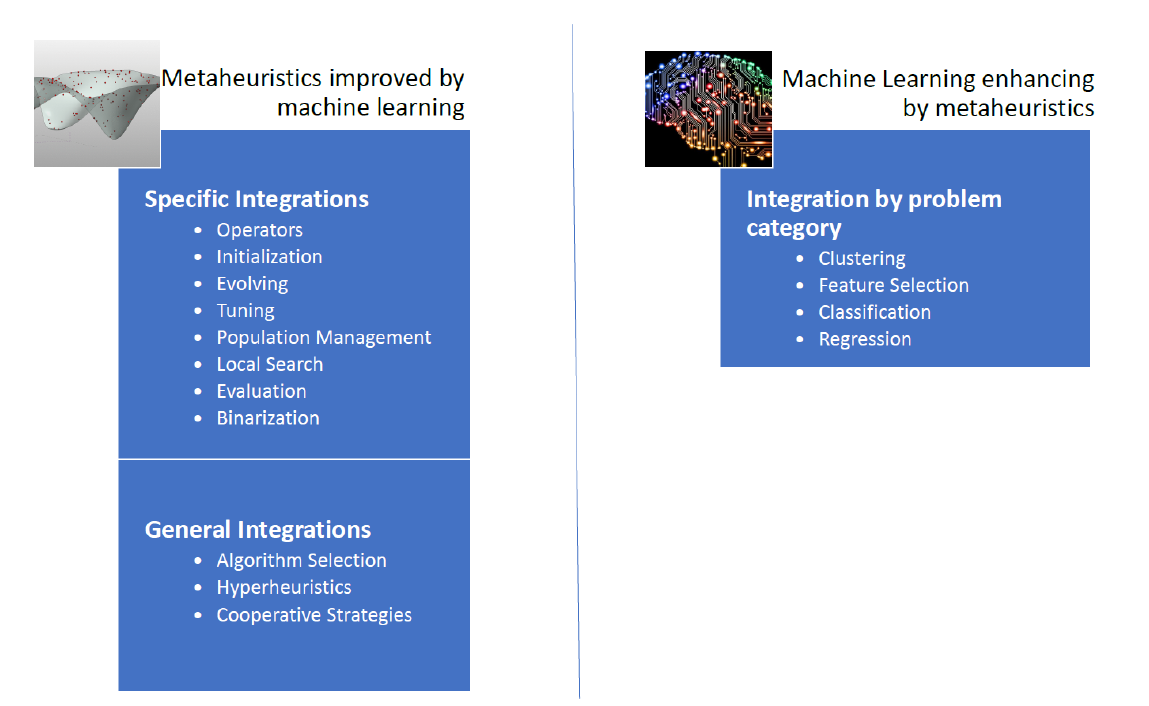
Figure 1. General scheme: Combining Machine Learning and Metaheuristics